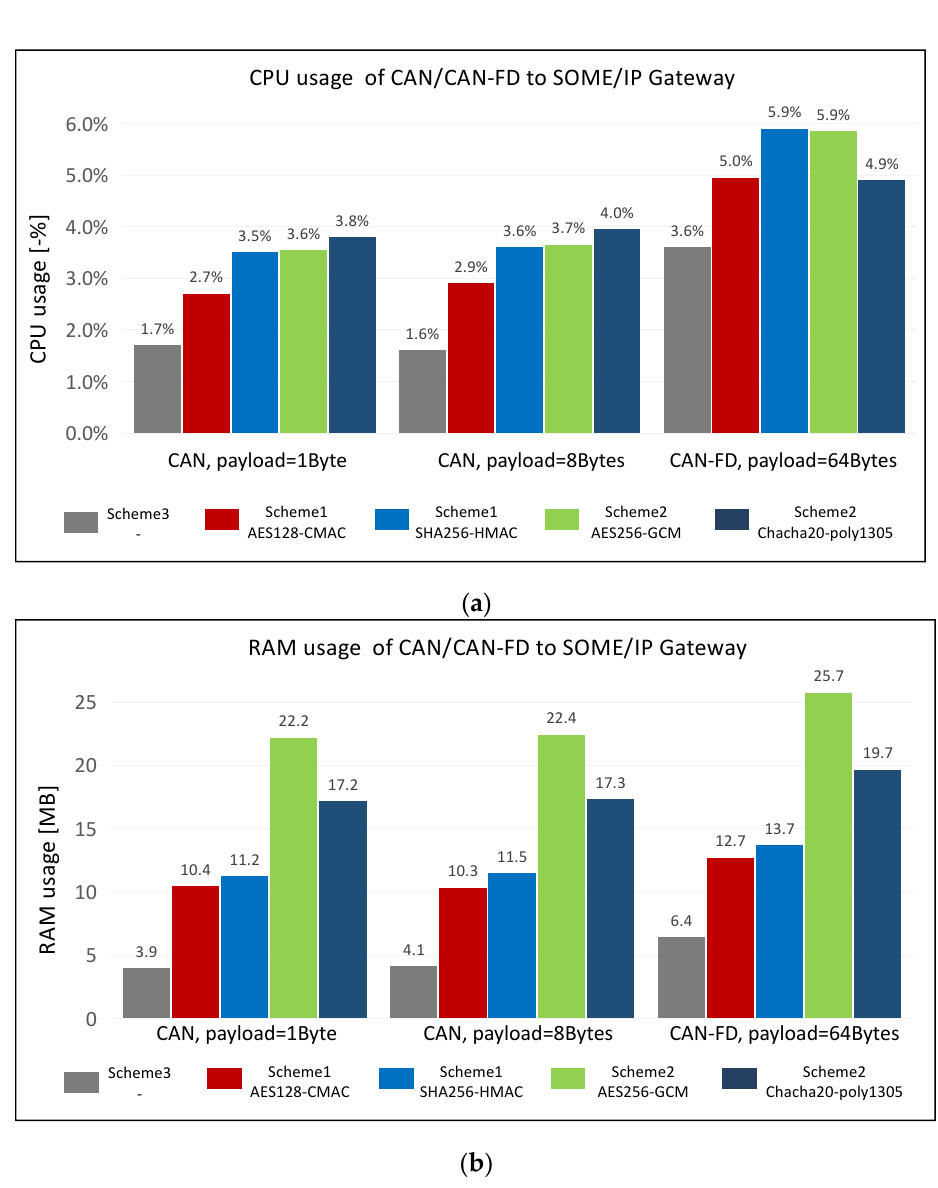
19 of 25 Analyzing the impact of security schemes on CPU usage and RAM usage: Scheme 3, without any security protection, takes up the least system resources. Scheme 2, which pro- vides both integrity and confidentiality protection, occupies more CPU and RAM than Scheme 1, which only provides integrity based on different lengths of CAN/CANFD mes- sages. This is because Scheme 2 requires encryption and MAC calculation, while Scheme 1 only requires MAC calculation. The overhead of AES128-CMAC is better than that of SHA256-HMAC in Scheme 1 since the NXP-S32G platform uses the Arm-A53 core, which has an AES acceleration encryption instruction set. The scheme of Chacha20-poly1305 has a slightly higher overhead with a shorter length of CAN/CANFD payload than that of AES256-GCM. However, the advantage of the Chacha20-poly1305 stream ciphers used in embedded devices becomes more obvious as the length of the CAN/CANFD payload in- creases, and the performance is better than that of AES256-GCM.